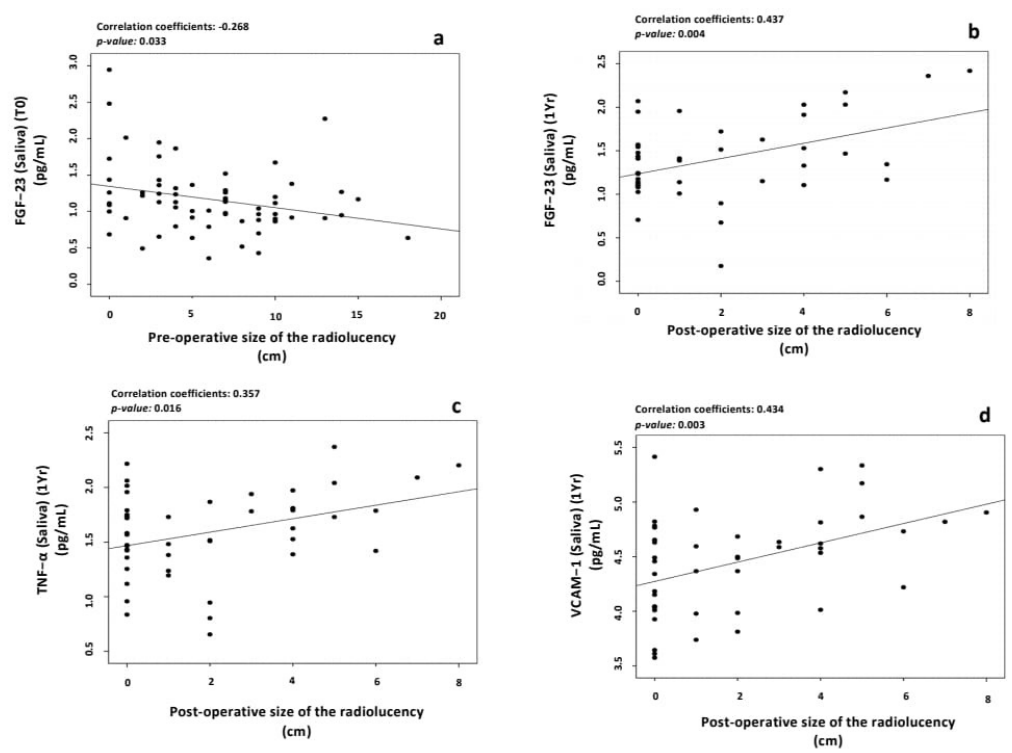
Figure 2. Correlation plot showing correlation between pre-operative (T0) and post-operative (1 Yr) salivary levels of inflammatory markers and the pre- and post-operative size of the radiolucency. ( a ) Correlation plot between pre-operative size of radiolucency and the pre-operative salivary levels of FGF-23; ( b ) Correlation plot between post-operative size of radiolucency and the 1 − year salivary levels of FGF-23; ( c ) Correlation plot between post-operative size of radiolucency and the 1 − year salivary levels of TNF- α ; ( d ) Correlation plot between post-operative size of radiolucency and the 1 − year salivary levels of VCAM-1.